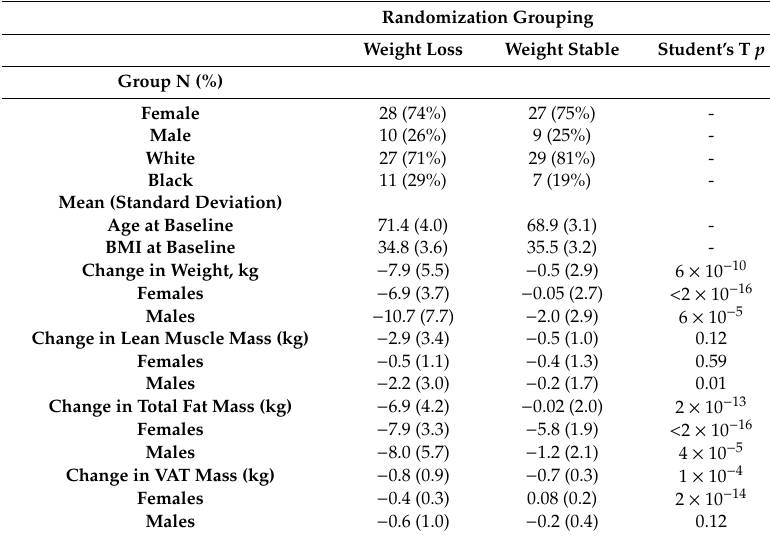
Table 1. Demographic characteristics and baseline and six-month change in body composition for weight loss and weight stable groups in metabolomics sample. BMI = body mass index, VAT = visceral adipose